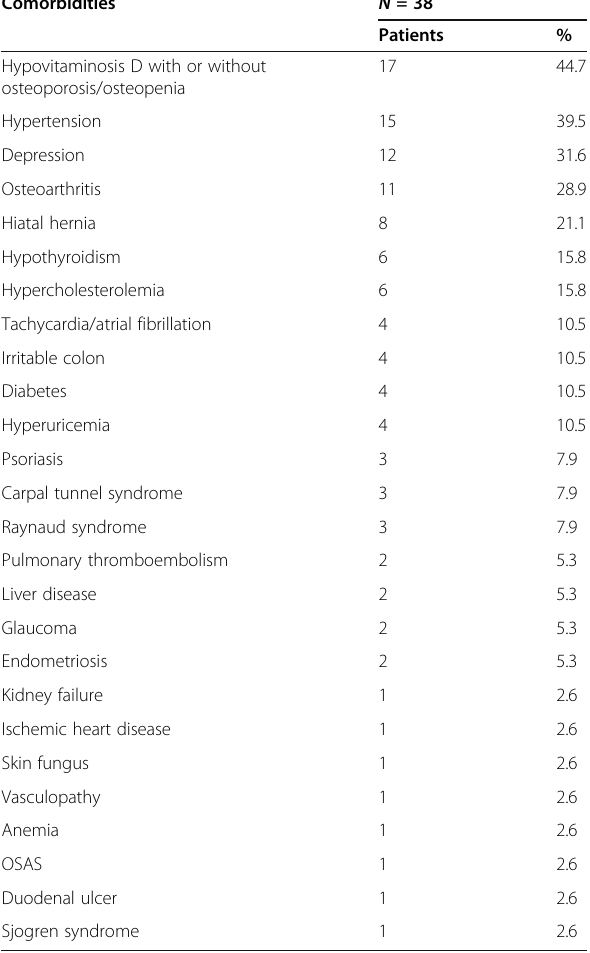
Table 3 Associated comorbidities in Italian fibromyalgia